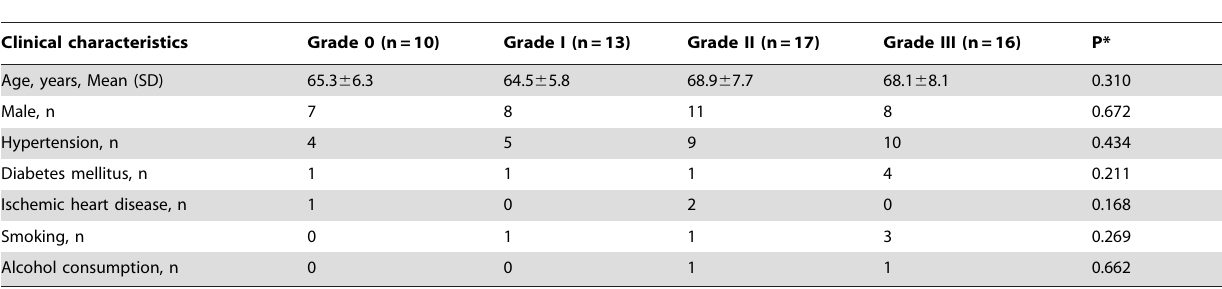
Table 1. Clinical characteristics of all participants (n=56) in each grade.